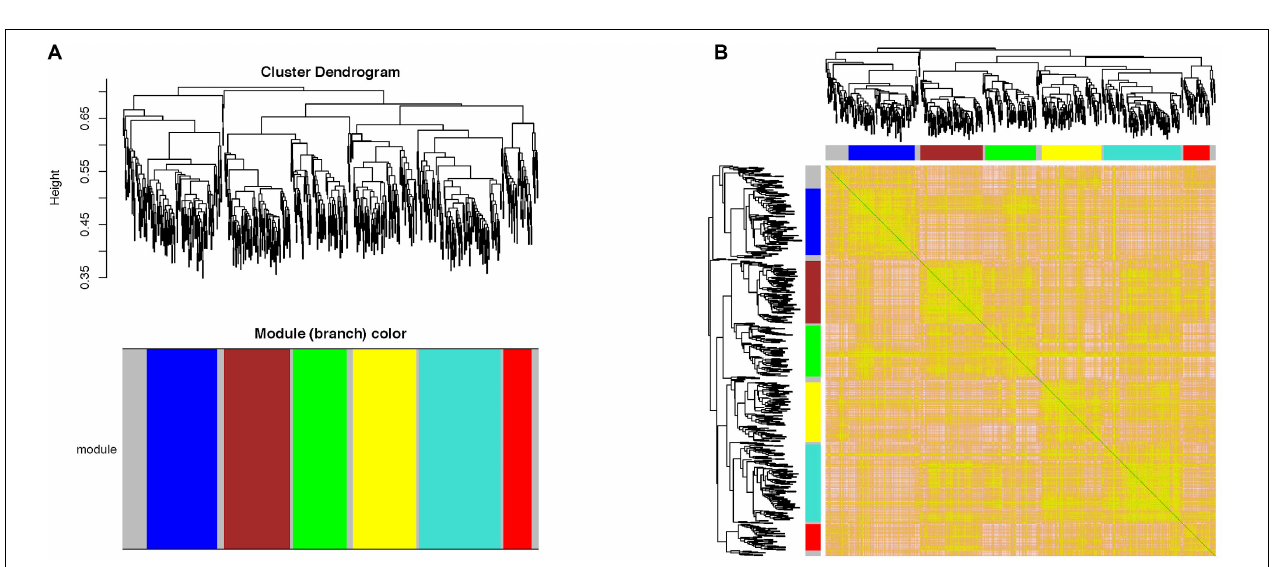
FIGURE 3 | Protein–protein interaction network results and the top 10 hub genes. (A) PPI network of DEGs created by STRING (red represent highly expressed genes in AR and green represent lowly expressed genes). (B) The top 10 hub genes identified by cytohubba. PPI, protein–protein interaction; DEG, differentially expressed gene; AR, allergic rhinitis.